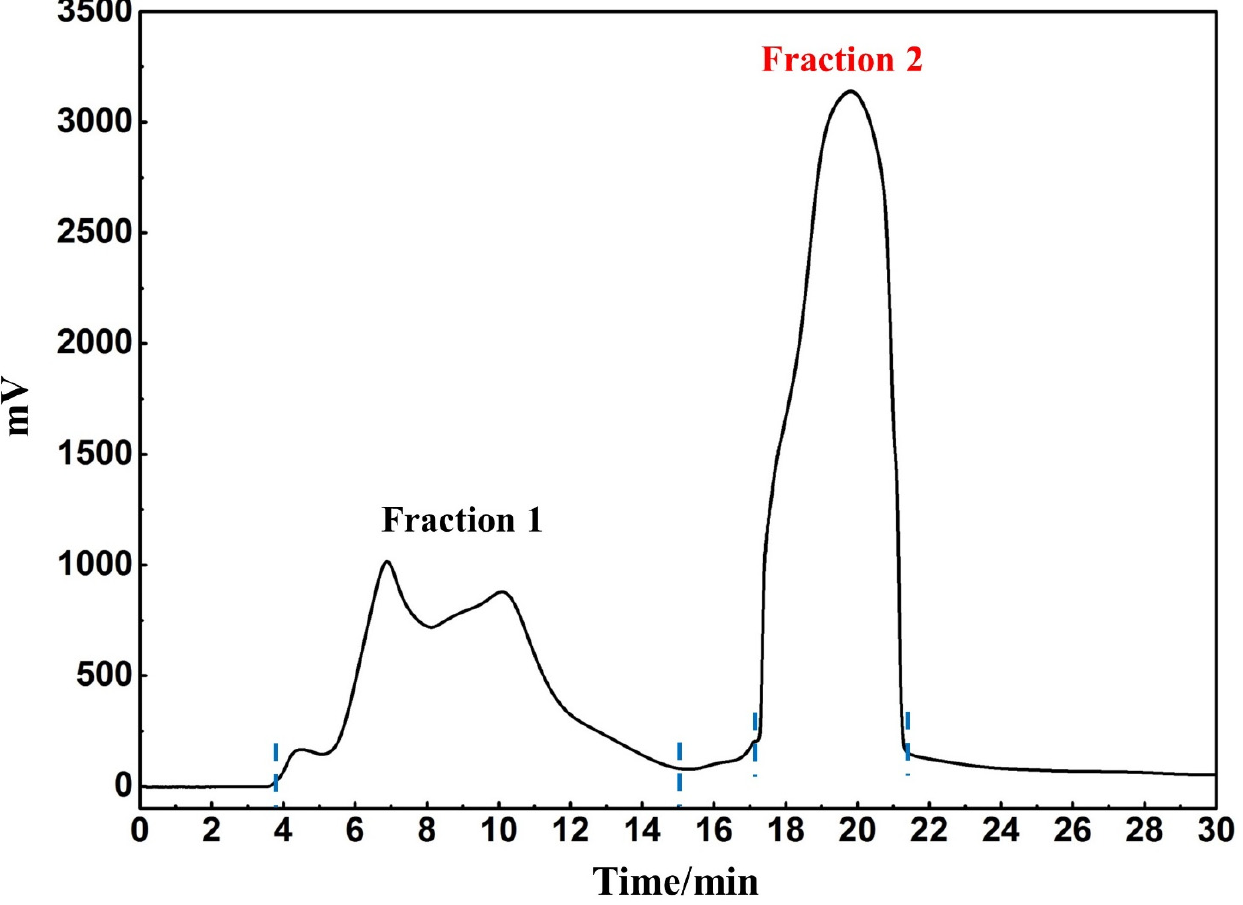
Figure 2. Pretreatment chromatogram of target components in Tulasnellaceae sp. with silica gel medium-pressure chromatographic tower; injection volume: 6.0 mL. Conditions: mobile phase A: dichloromethane, B: methanol; gradient: 0–30 min, 0–35% B; monitoring wavelength: 270 nm; flow rate: 59.0 mL/min.